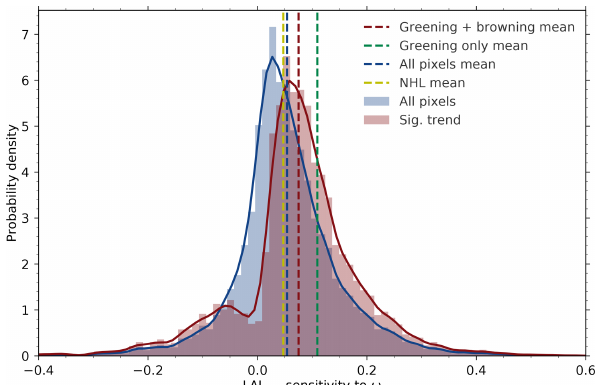
Figure 3. Histograms and associated probability density functions (Gaussian kernel density estimation) of observed LAI max sensi- tivity to ω at pixel scale for the northern high-latitudinal band ( > 60 ◦ N, data from AVHRR sensor). Blue depicts the distribution of LAI max sensitivities of all pixels and red is for pixels with statis- tically significant (Mann–Kendall test, p < 0 . 1) greening or brown- ing trends (the dashed lines denote the respective mean value). The green dashed line shows the mean value of “greening” pixels only, whereas the dashed yellow line shows the LAI max sensitivity to ω for the entire northern high-latitudinal